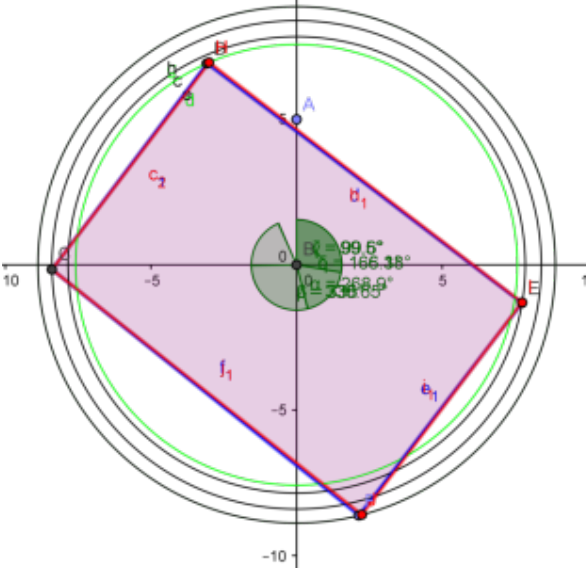
Figure 10: Room 1 construction from original range finder measurements (red) and interval valued homotopy continuation calibration of horizontal angles measurements